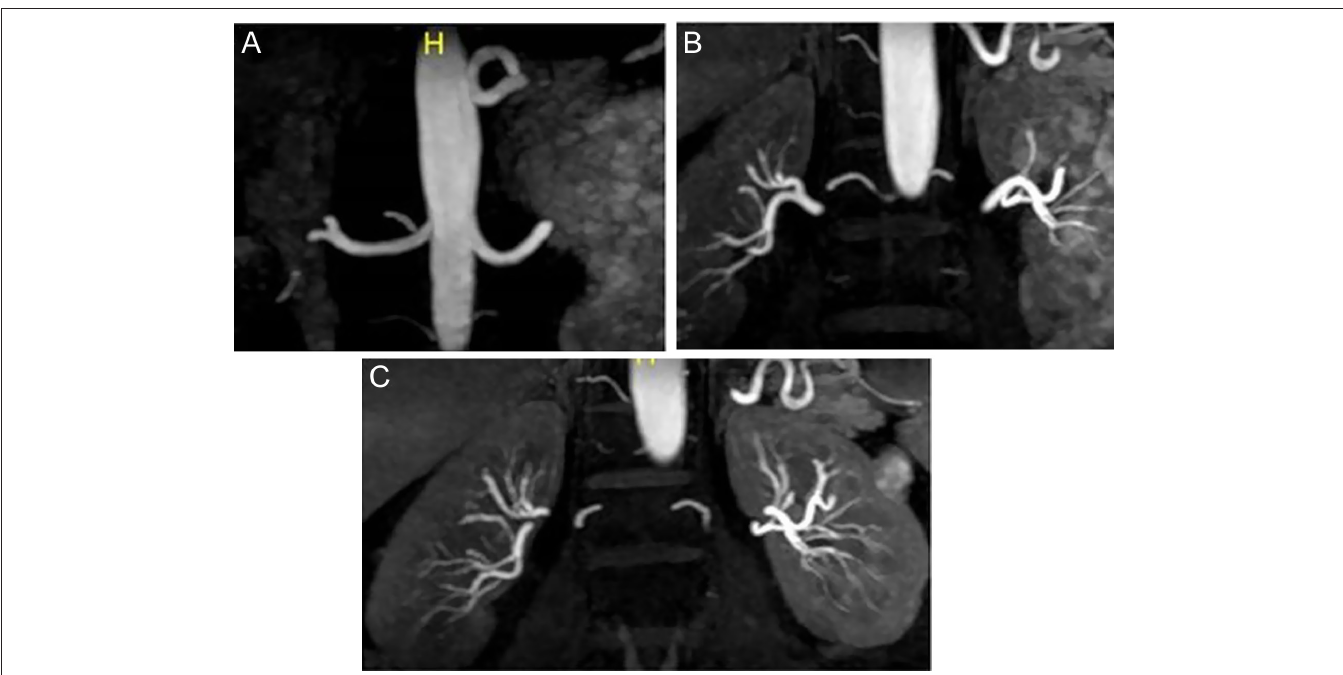
Figure 1. Inhance sequence in a 44-year-old female patient. Coronal reformatted Maximum Intensity Projection (MIP) images for (A) main renal arteries (VP 4), (B) segmental branches (VP 4), and (C) interlober branches (VP 3).